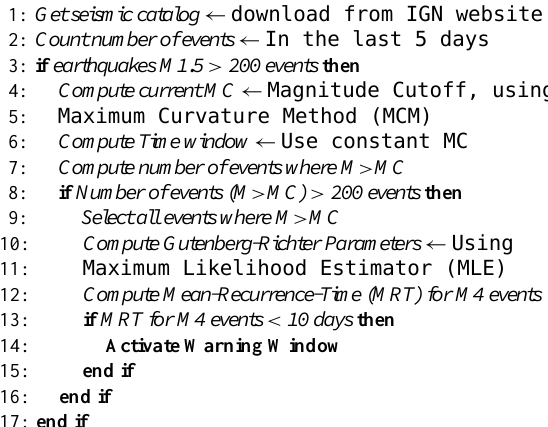
volcanic process